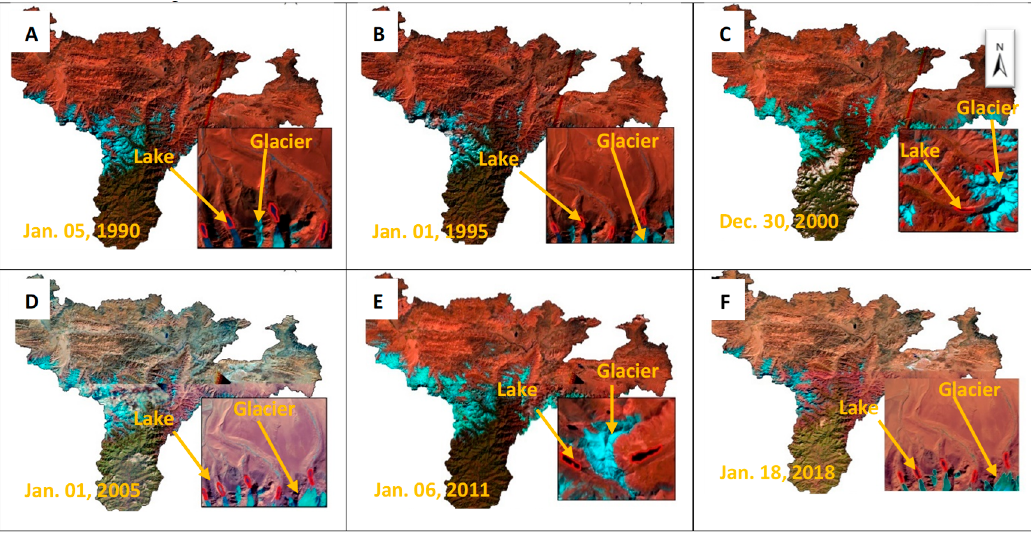
Figure 3. Remote sensing using satellite images to identify glaciers and glacial lakes for the years ( A ) 1990, ( B ) 1995, ( C ) 2000, ( D ) 2005, ( E ) 2011, and ( F ) 2018. 1990, ( B ) 1995, ( C ) 2000, ( D ) 2005, ( E ) 2011, and ( F )